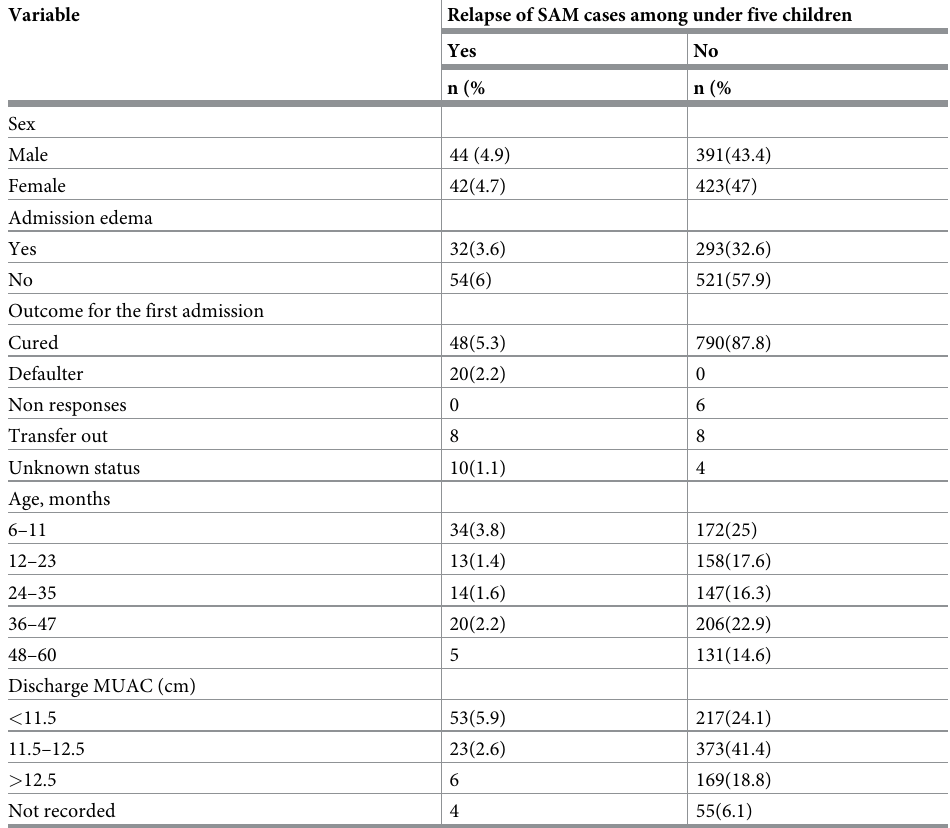
Table 3. Relapsed cases with other variables severe acute under nourished under five children in Hadiya Zone, SNNPR, Ethiopia from 2014/2015-2019/2020 (n = 900).